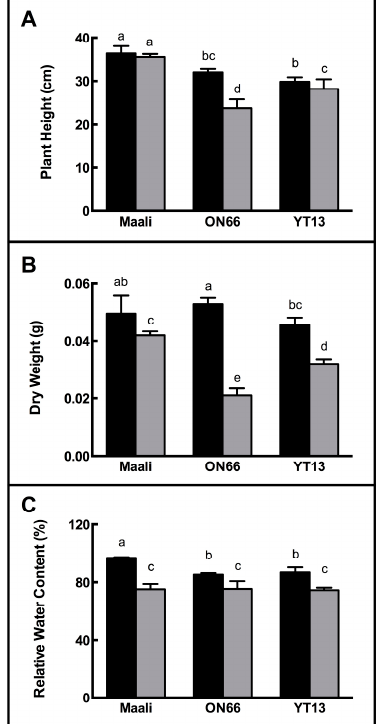
Figure 1. Effects of osmotic stress induced by PEG-6000 on Plant Height ( A ), Dry weight (DW) ( B ) and Relative Water Content (RWC) ( C ) in three durum wheat genotypes. Measurements in control plants are in black bars; activities in stressed plants are in grey bars. Data are the average of at least 3 determinations ± standard error. Letters indicate homogenous data.